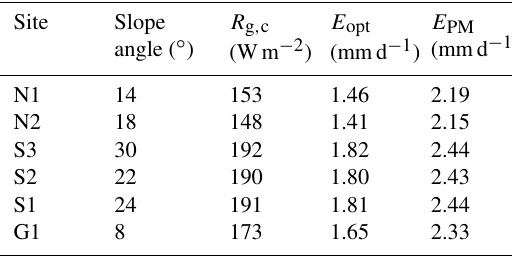
Table 4. Site topographic characteristics with average inclination of each site is given in column “slope angle”. Column, R g , c is the average global radiation R g , c , and E opt and E PM are all averaged for the vegetation period 10 June–20 October. Values of site G1 are measured directly, values of the forested sites are estimated by the topographic correction of solar radiation.